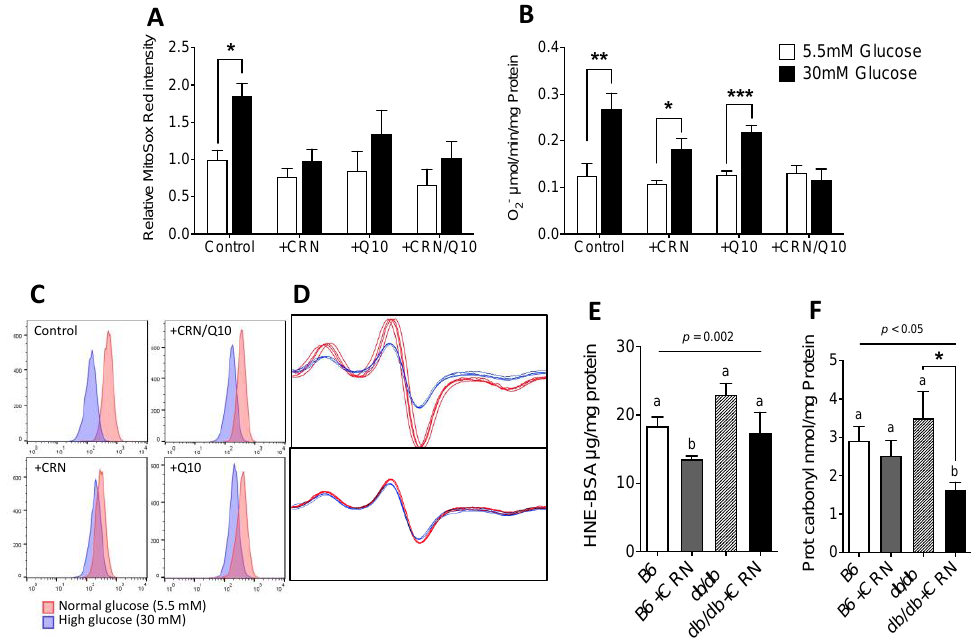
Figure 2. FACS results, expressed as median PE-Texas Red emission at ex488nm in HepG2 cells labeled with MitoSox Red. Cells were either treated with sham, 10 mM CRN, 10 µ M CoQ or a combination of CRN and CoQ at 10 mM and 10 µ M, respectively. Results are presented as values relative to control ( A ). Representative FACS histograms of MitoSox Red labeled HepG2 cells as presented ( C ). Superoxide production in HepG2 cells measured using CMH spin trapping in EPR spectroscopy ( B ). FACS and EPR experiments are compiled results from 4 separate experiments. Results from EPR were normalized to total protein content. EPR spectra for cells treated with sham and a 10 mM CRN/10 µ M CoQ combination shown ( D ). 4-Hydroxynonenal content in mouse liver lysates measured by 4-HNE adduct competitive ELISA ( E ) for treated and untreated control (C57B) and db/db mice. Protein Carbonyl ELISA results from the same animals ( F ). ELISA results were normalized by total protein content. n = 5 for all groups. All values are represented as mean ± SEM. Statistical analysis was performed using Student’s t -test ( A , B ) and one-way ANOVA with multiple comparison differences denoted ( E , F ). (a,b) Different letters indicate significant differences in mean values from repeated-measures ANOVA ( p < 0.05). A p -value of <0.05 was considered significant. *, ** and *** denotes a significance of p < 0.05, p < 0.01 and p < 0.001, respectively in all